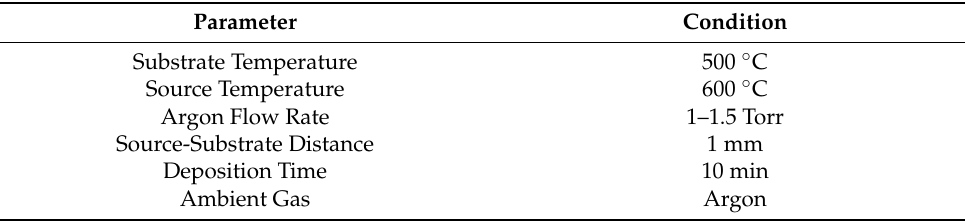
Table 2. Growth parameters for CSS deposited CdTe films.